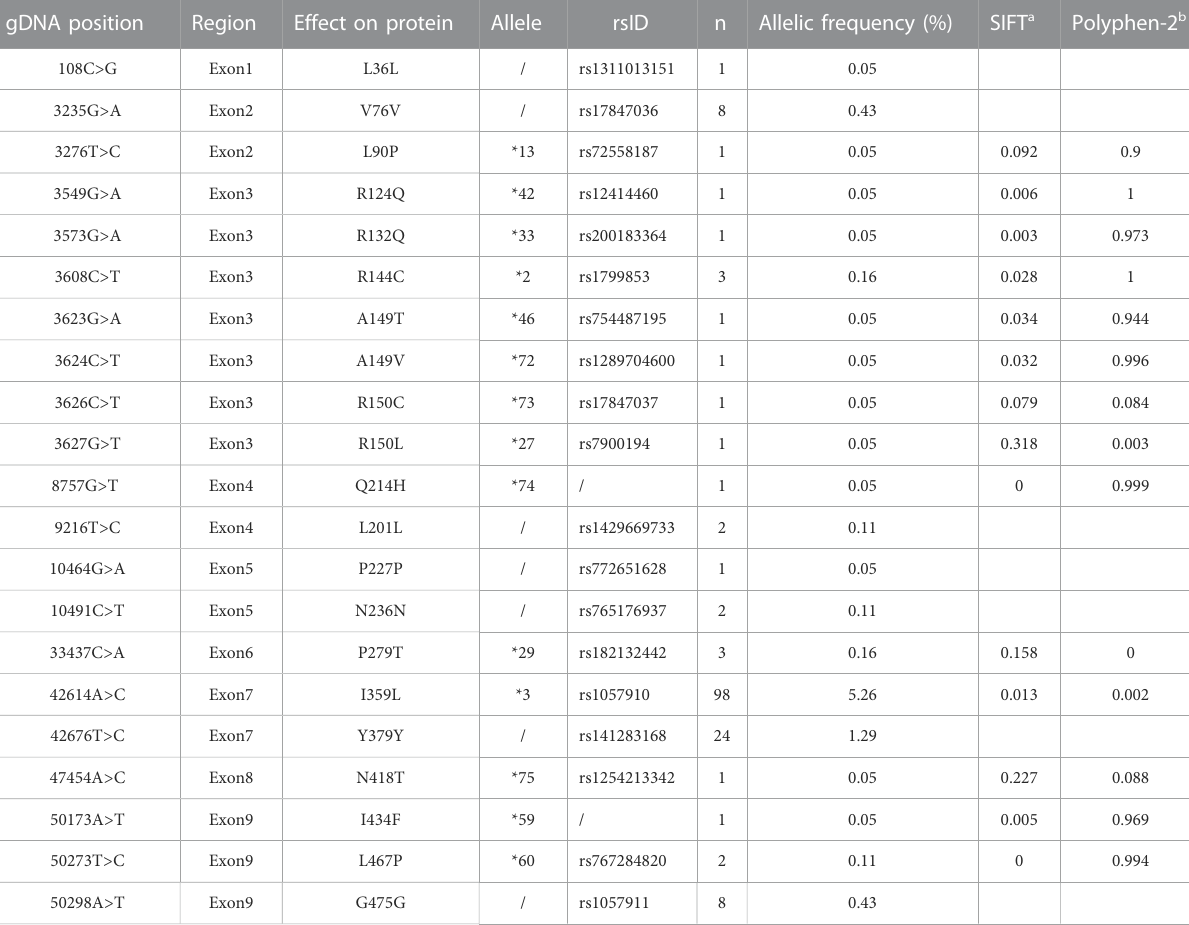
TABLE 2 Synonymous and missense mutations of CYP2C9 in the Chinese Han population. gDNA